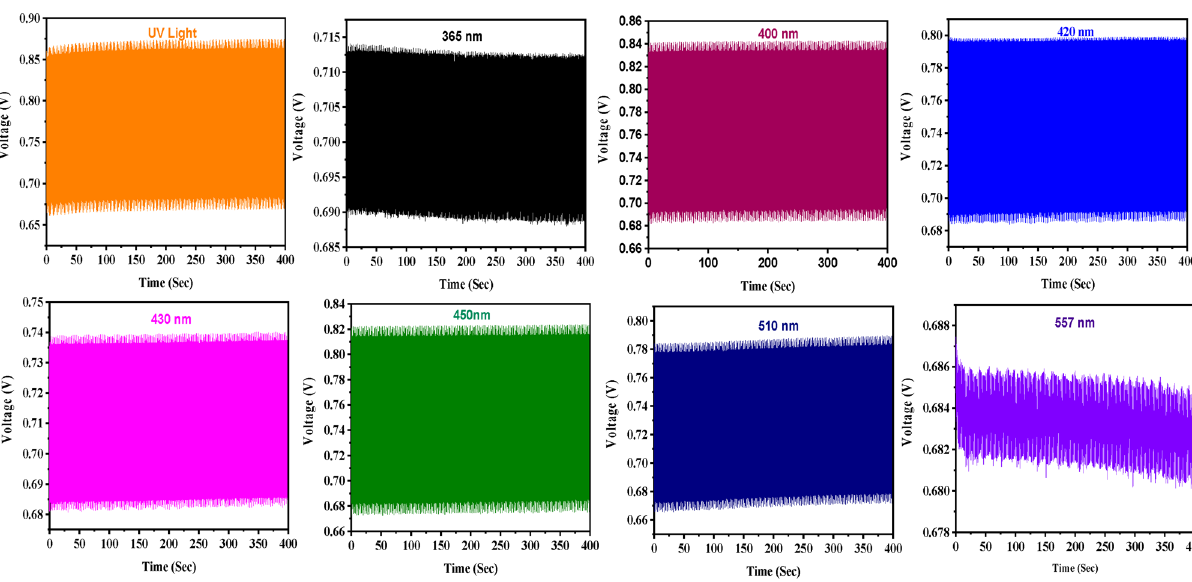
Figure 5. Sensitivity analysis of NiS/ZnO modified perovskite electrode with different